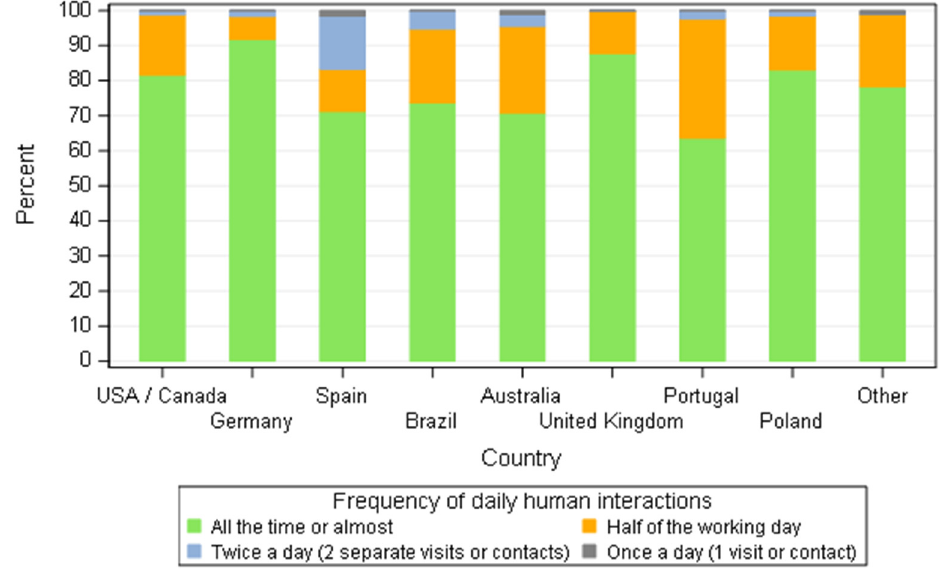
Figure 5. Frequency of daily human interactions distribution according to dog breeders by country—all responders ( n = 668).